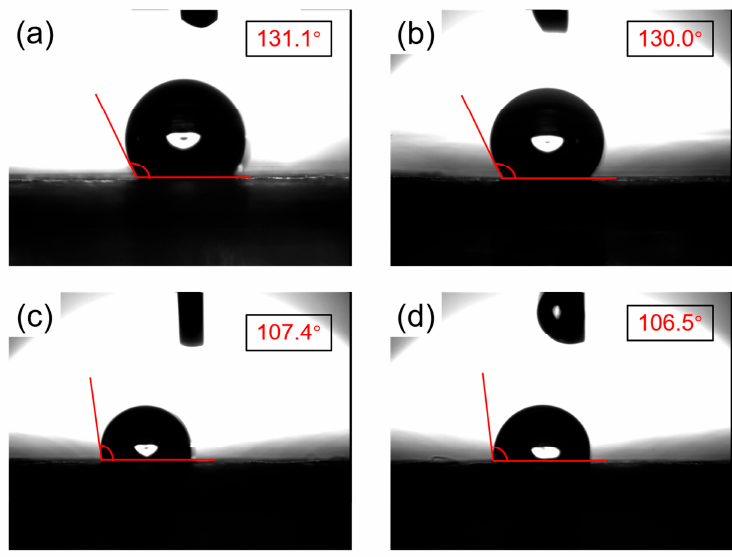
Figure 4. Optical contact angle measurements of PTFE membranes for air filtration: ( a , b ) nanofiber, ( c , d ) microfiber [39].